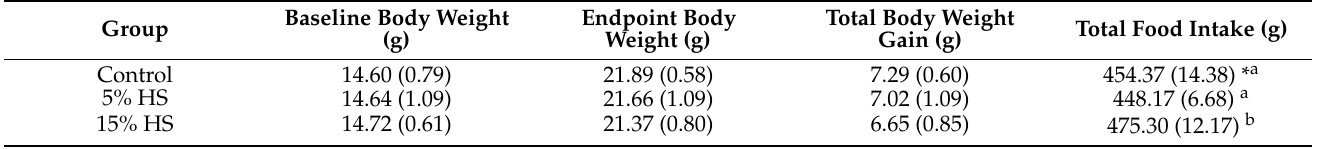
Table 2. Body weight at baseline and endpoint and total weight gain and food